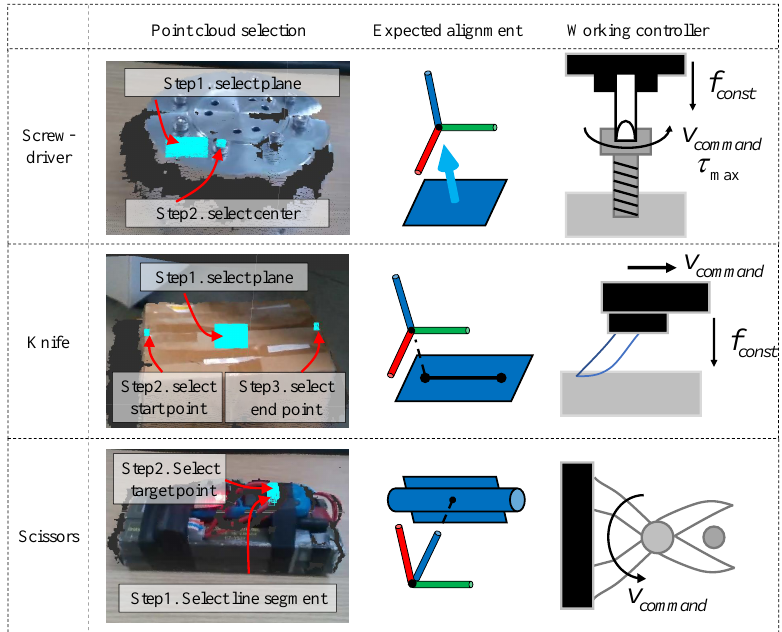
Figure 7. Point cloud selection and working controller of different tools.